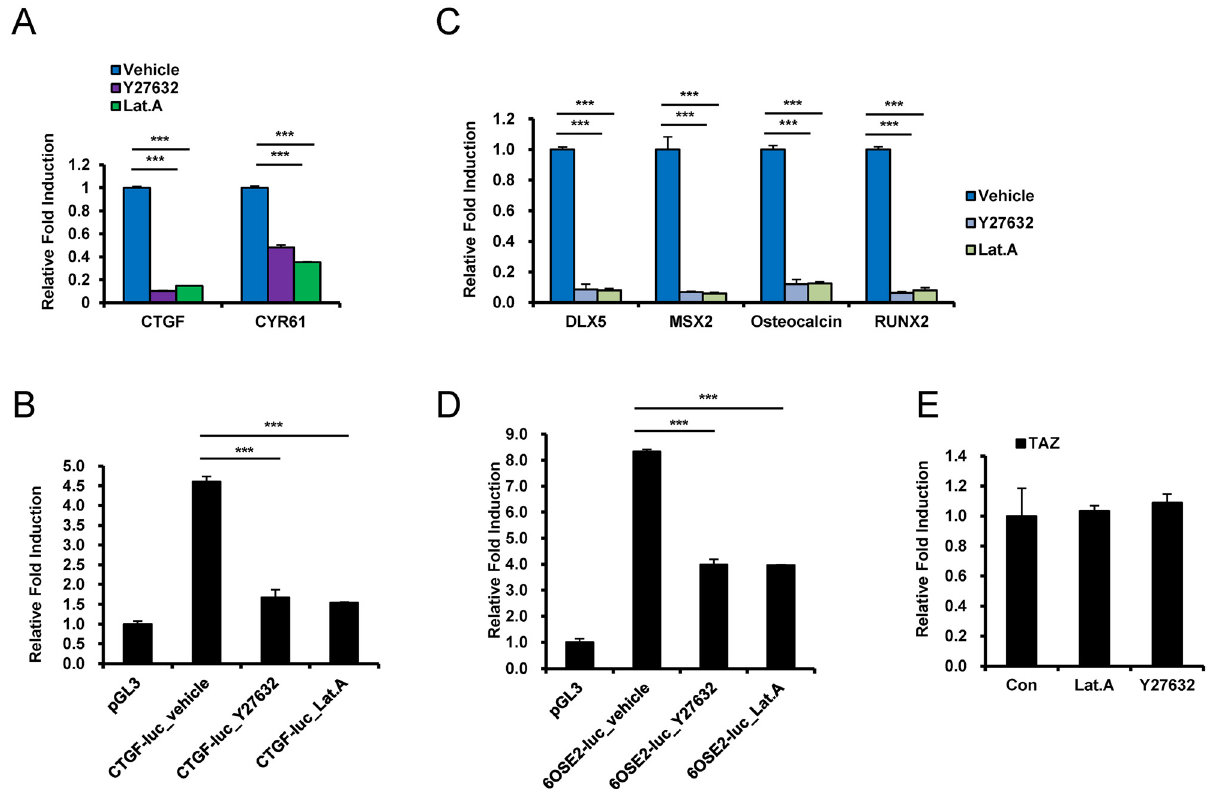
Fig 6. Inhibition of ROCK/F-actin represses the transcriptional activity of TAZ in hMSCs. (A) hMSCs cultured on a 4.47kPa hydrogel were treated with a ROCK inhibitor (Y27632, 50 μ M) or an F-actin inhibitor (latrunculin A, 0.5 μ M). After 12 h of treatment, total RNA was prepared, and CTGF and CYR61 expression was assessed by qRT-PCR. (B) The CTGF-luc reporter gene construct or the pGL3-basic control vector was transfected into hMSCs, and after 16 h, the transfected cells were plated on 4.47 kPa hydrogels. After 24 h, luciferase reporter gene activity was analyzed. To inhibit ROCK or F-actin, cells were pretreated with 50 μ M Y27632 or 0.5 μ M latrunculin A 12 h before reporter gene analysis. A Renilla luciferase-expressing vector was used as a transfection control. Luciferase activity was normalized to Renilla luciferase activity. (C) hMSCs on 4.47 kPa hydrogels were differentiated into osteoblasts